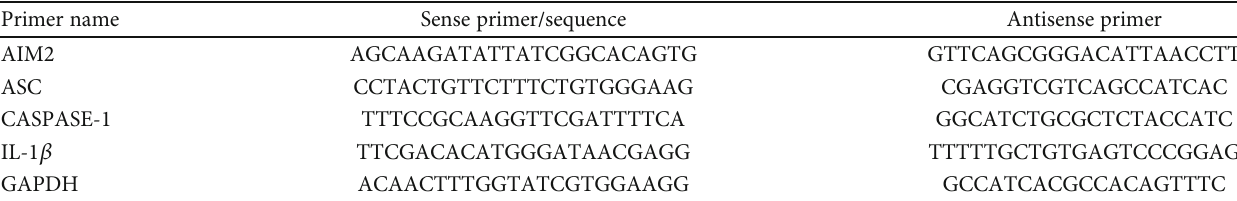
Table 4: qPCR primers used in this